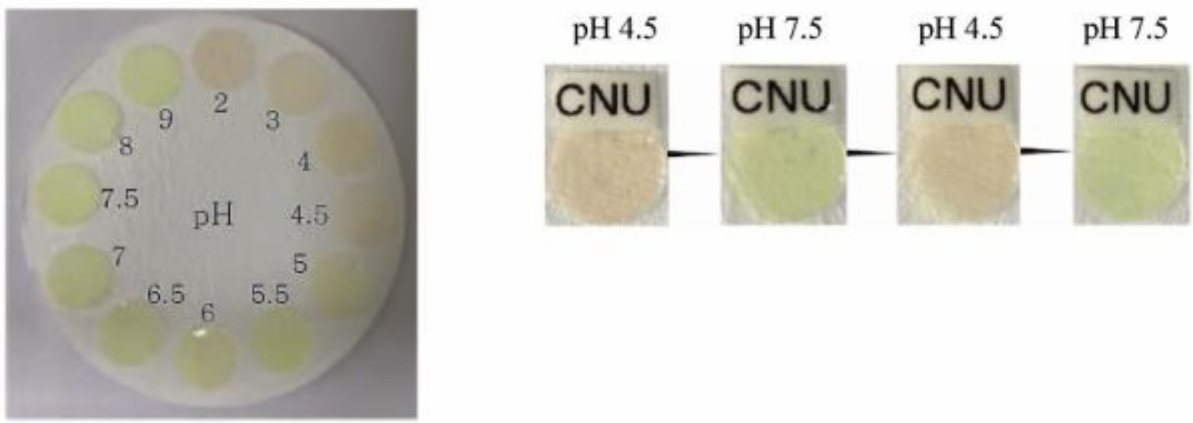
Figure 14. Visual color transition of the MF-C6-Nf membrane at different pHs (pH 2, 3, 4, 4.5, 5, 5.5, 6, 6.5, 7, 7.5, 8, and 9) under sunlight and images of reversible color of the MF-C6-Nf membrane when it was exposed to pH 4.5 and 7.5 under sunlight. Reproduced with permission from [119]. Copyright 2020©,